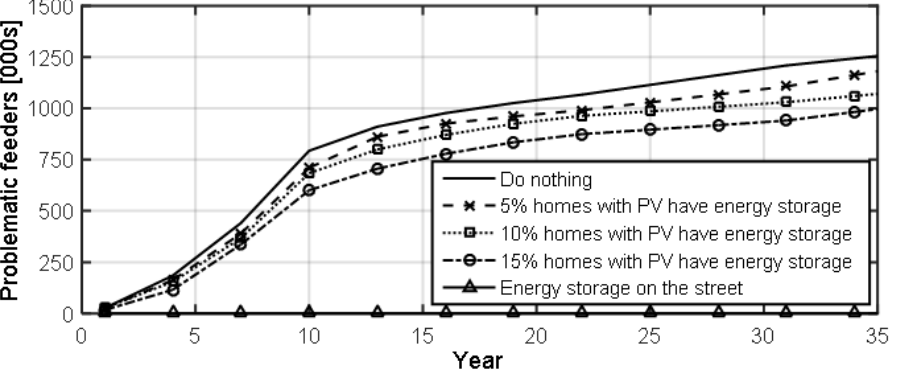
Figure 7. Number of problematic LV feeders in the entire network according to medium PV scenario with no storage, storage randomly located in different percentages of homes and storage located by the DNO.